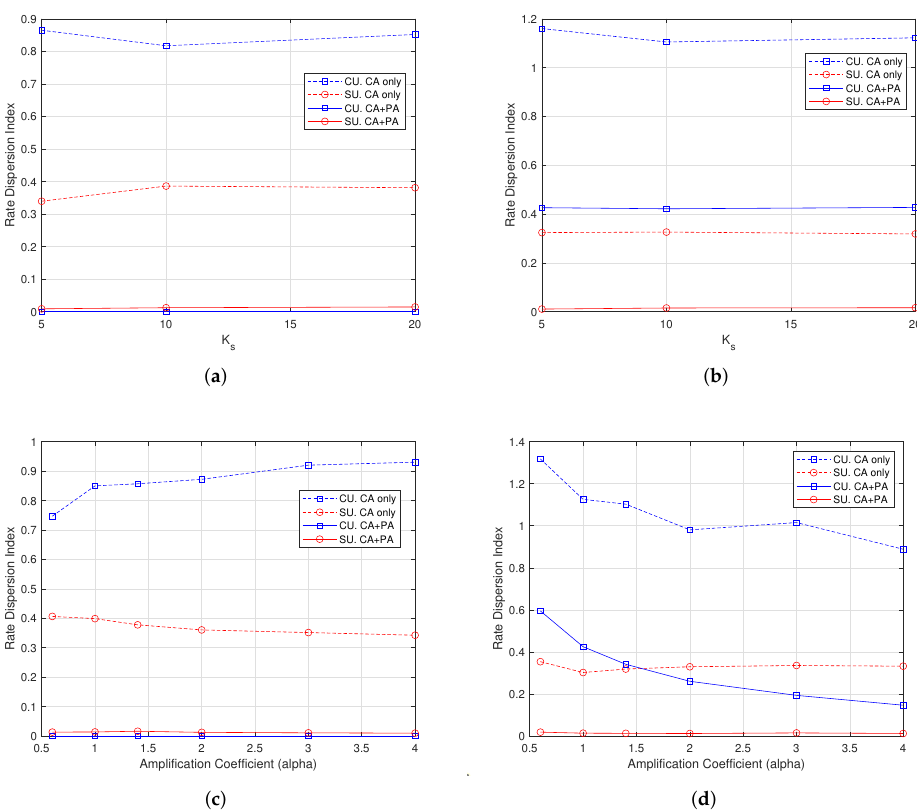
Figure 6. Rate dispersion index with F = 1, K c = 30 users, 100 iterations. ( a ) Varying K s , α = 1, CE-aware; ( b ) varying K s , α = 1, CE-unaware; ( c ) varying α , K s = 10, CE-aware; ( d ) varying α , K s = 10,